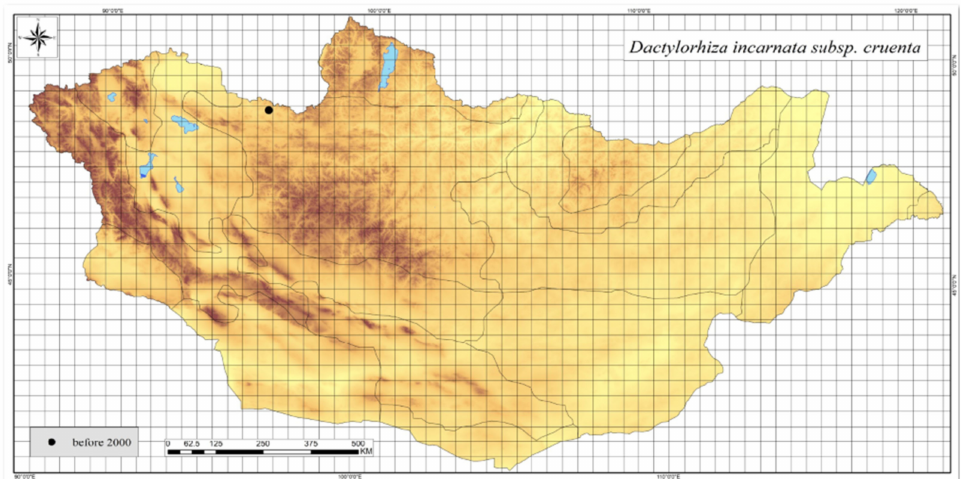
Figure A9. Distribution map of Dactylorhiza incarnata subsp. cruenta in Mongolia.